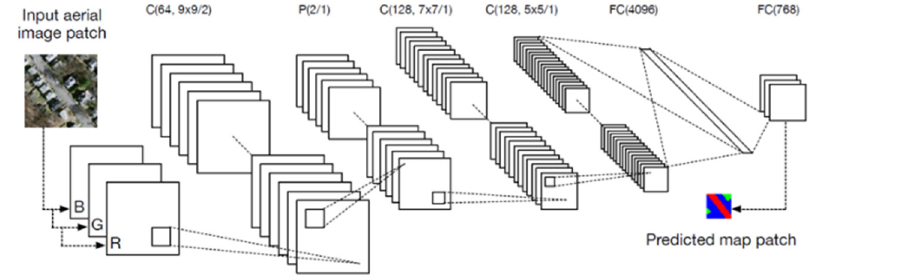
Figure 2. the CNN architecture (Saito and Aoki 2015)